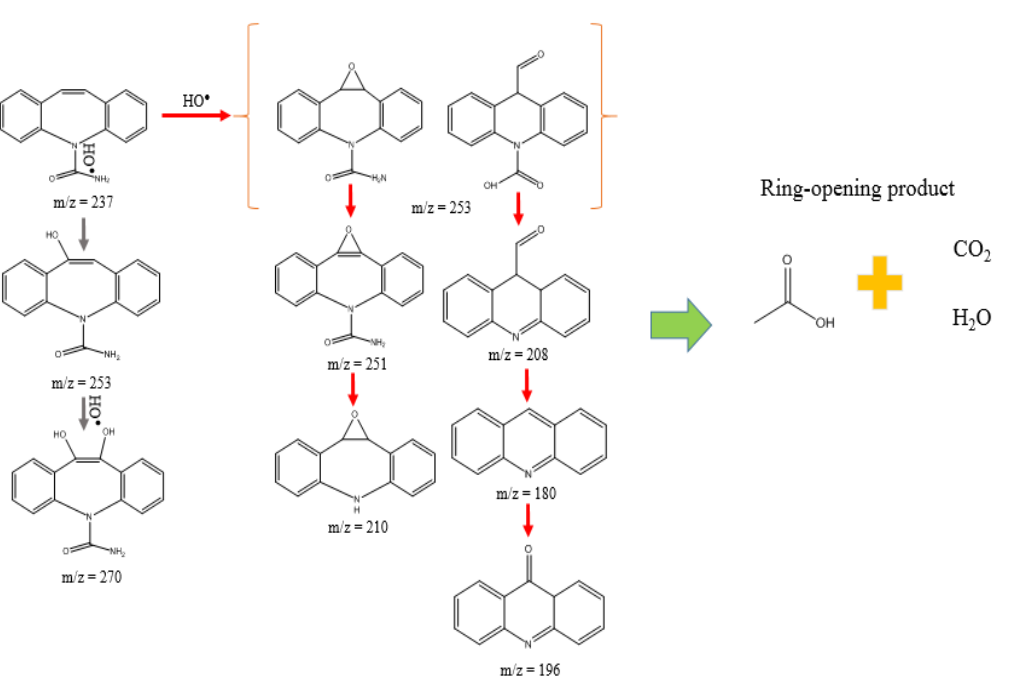
Figure 7. Proposed by-products of CBZ degradation in visible light.